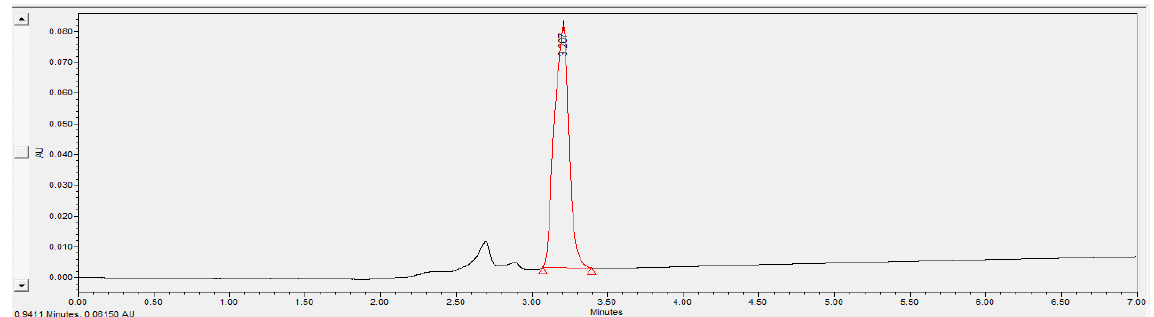
Figure 15. Chromatograms of wastewater samples containing phenols before treatment using Fe-Cu internal microelectrolysis material.